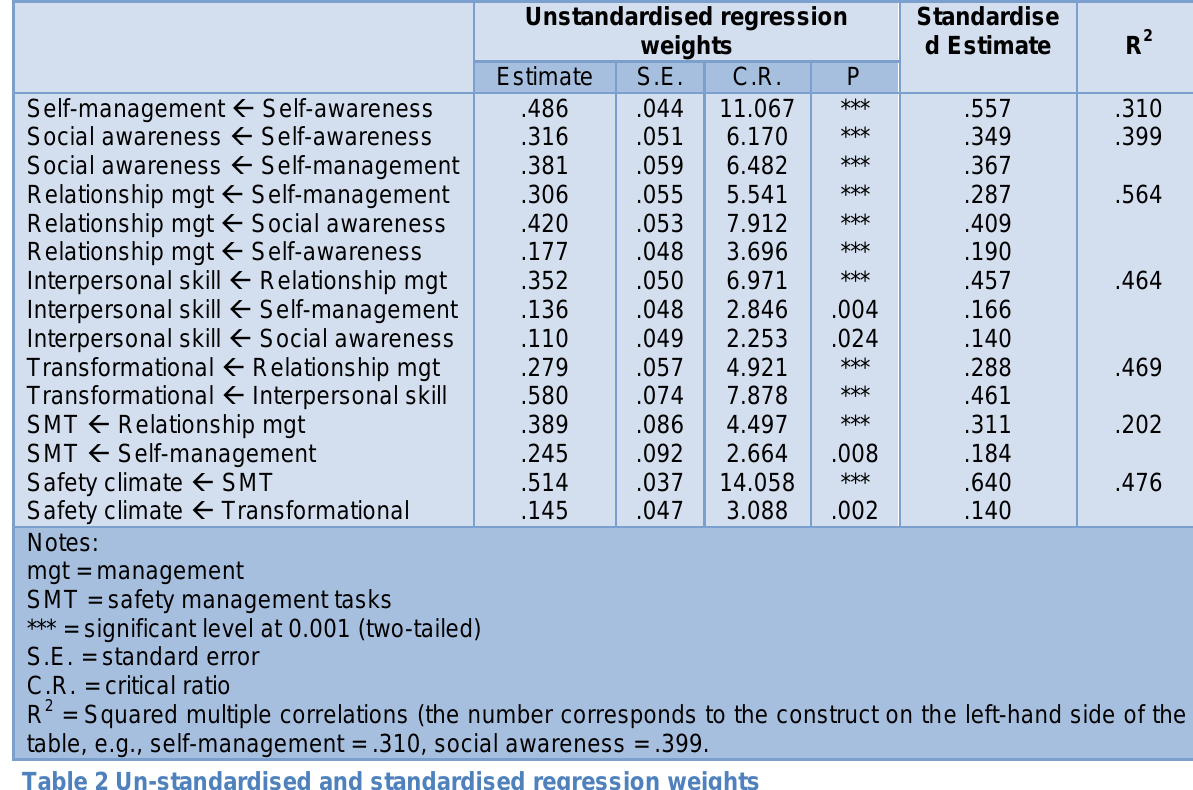
table, e.g., self-management = .310, social awareness = .399. Table 2 Un-standardised and standardised regression